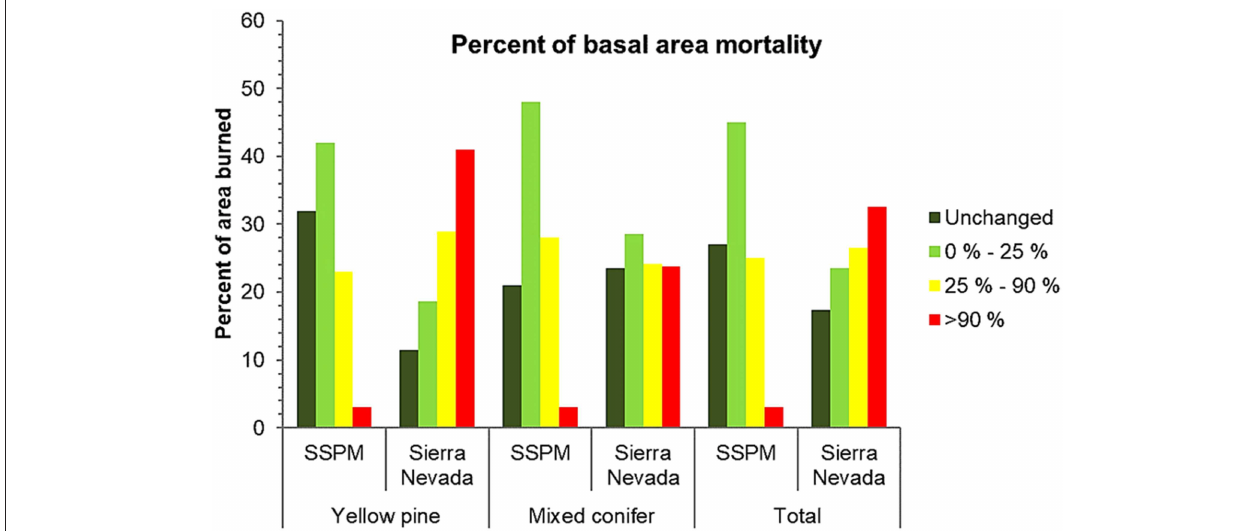
FIGURE 10 | Comparison of mean fire severity distributions in the Sierra de San Pedro Mártir (SSPM) National Park, Mexico, and the Central Sierra Nevada of California for the period 1984–2010. Sierra Nevada data from J.D. Miller, USDA Forest Service, McClellan, California. Darker green bars represent 0% change, light green bars represent low-severity fire (0–25% change), yellow bars represent moderate-severity fire (25–90% change), and red bars represent high-severity fire ( > 90%change, Rivera-Huerta et al., 2016). Yellow pine is another name for Jeffrey